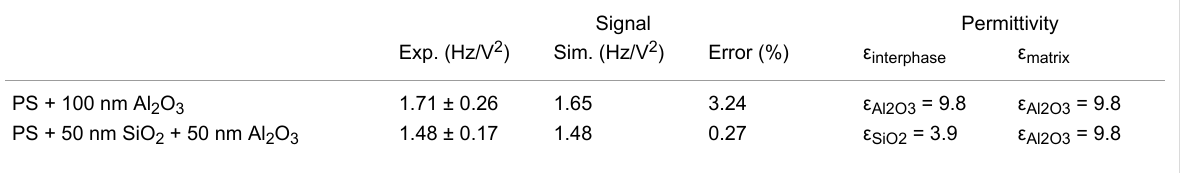
Table 3: Experimental data and simulations for PS + 50 nm SiO 2 + 50 nm Al 2 O 3 and PS + 100 nm Al 2 O 3 samples. The subsurface SiO 2 layer displays a dielectric permittivity value of 3.9 (error =